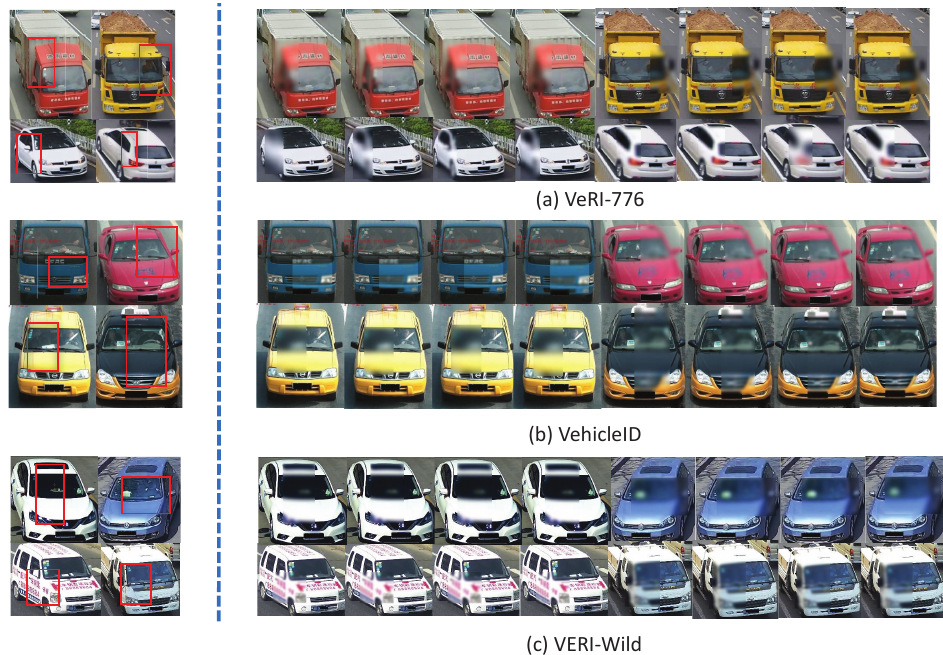
Figure 9. Visualization of the original sample and four augmented samples. ( a ) shows four samples from VeRi-776. ( b ) shows four samples from VehicleID. ( c ) shows four samples from